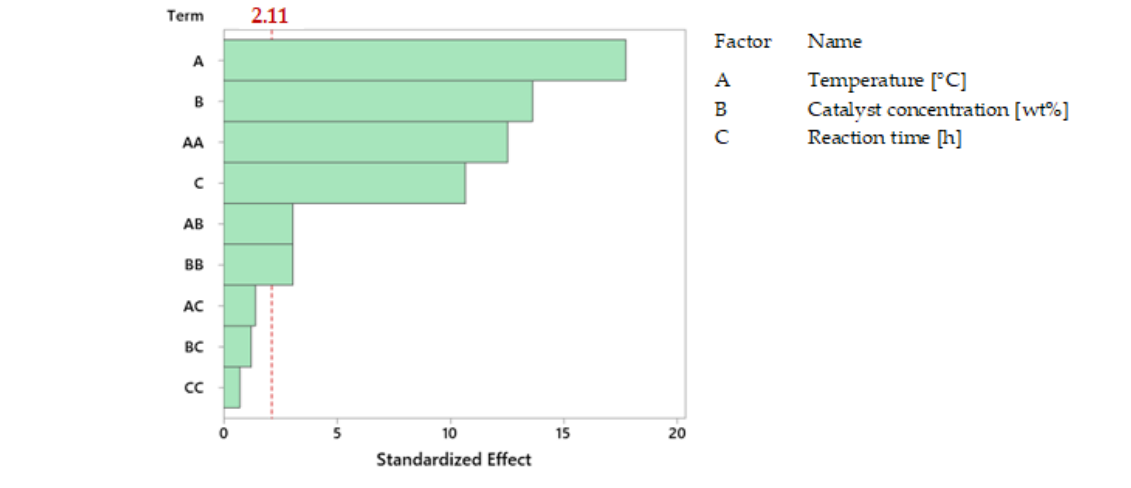
Figure 9. Pareto chart of standardized e ff ects; response is BP selectivity (mol%) ( α =